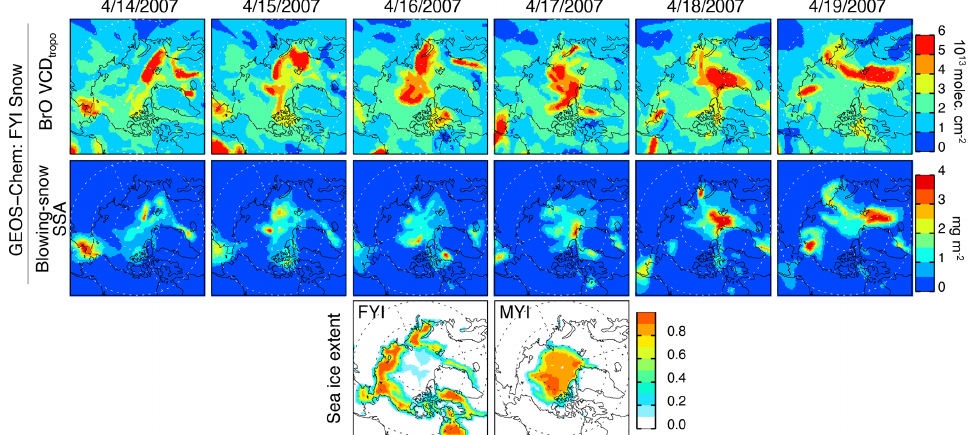
Figure 7. Daily 14–19 April 2007 (in the date format of month/day/year) distribution of BrO VCD tropo and blowing-snow SSA burden from the GEOS-Chem FYI Snow simulation. The bottom row shows the distribution of sea ice extent for FYI and